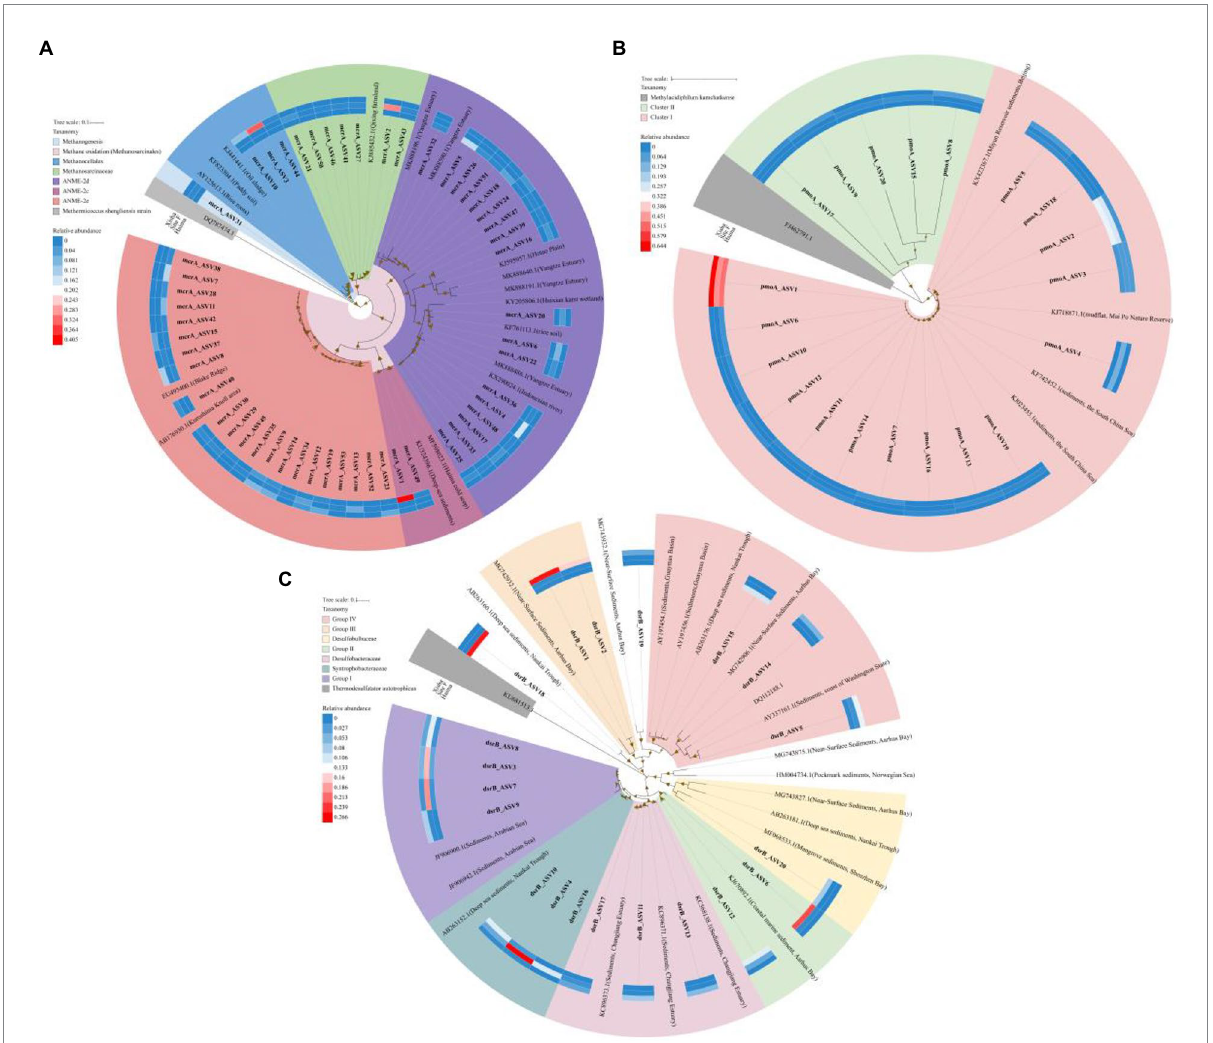
FIGURE 4 Maximum likelihood phylogenetic trees for mcr A gene with top 53 ASVs (accounting for >95% of the total retrieved mcr A gene sequences) (A) , pmo A gene of top 20 ASVs (accounting for >85% of the total retrieved pmo A gene sequences) (B) and dsr B gene of top 20 ASVs (accounting for >49% of the total retrieved dsr B gene sequences) (C) . Bootstrap values over 50% based on 1,000 replicates were shown. The abundance of the ASVs in each region was shown in the heatmap referred to the color